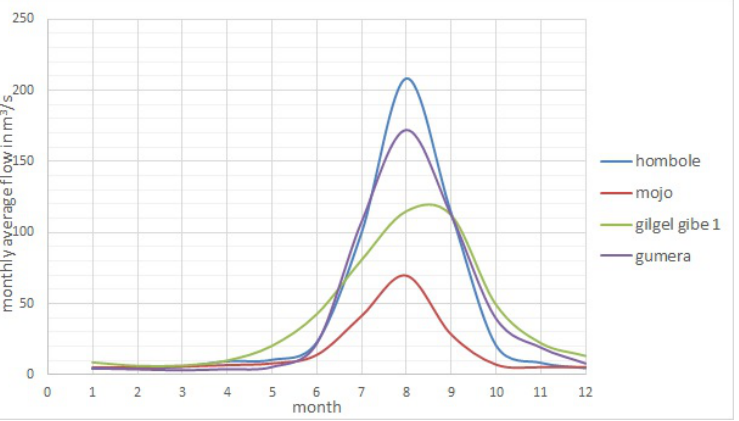
Figure 2. The monthlyaverage rainfall of each watershed under our consideration.